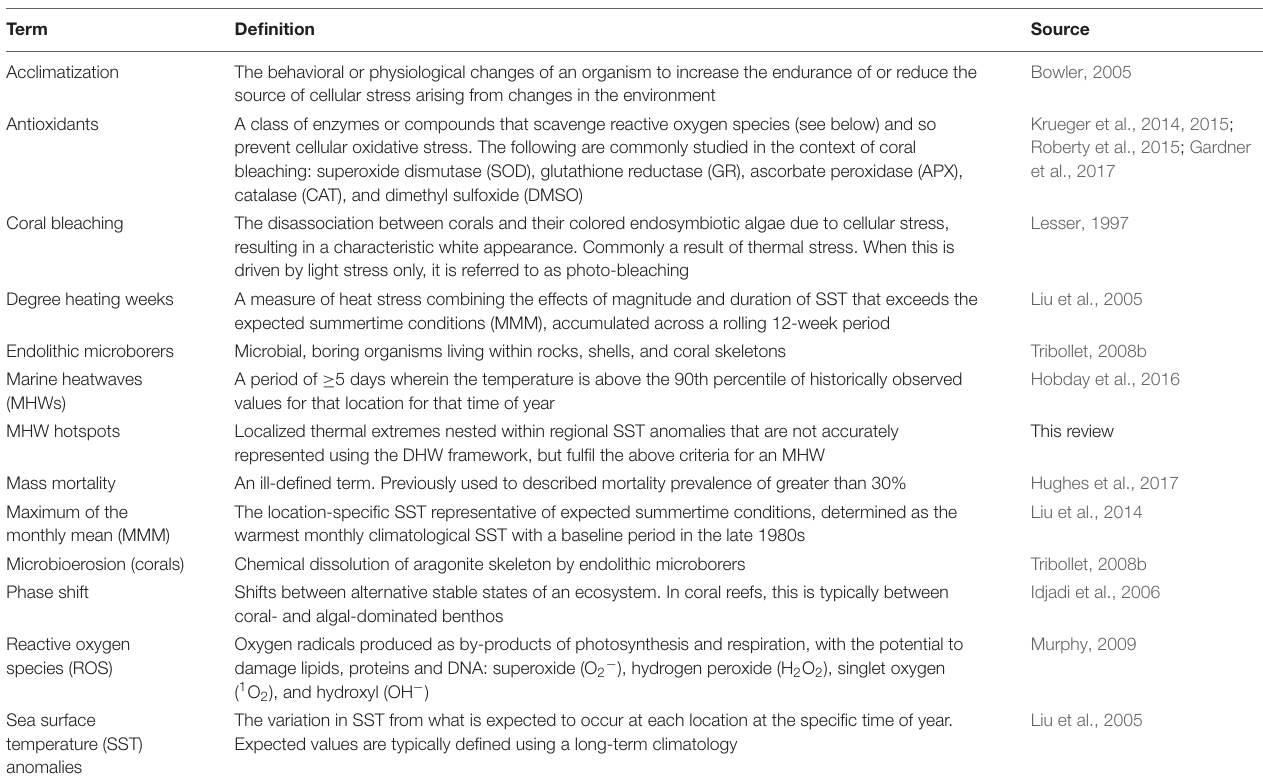
TABLE 1 | Common and key terms, and their definitions, used in this